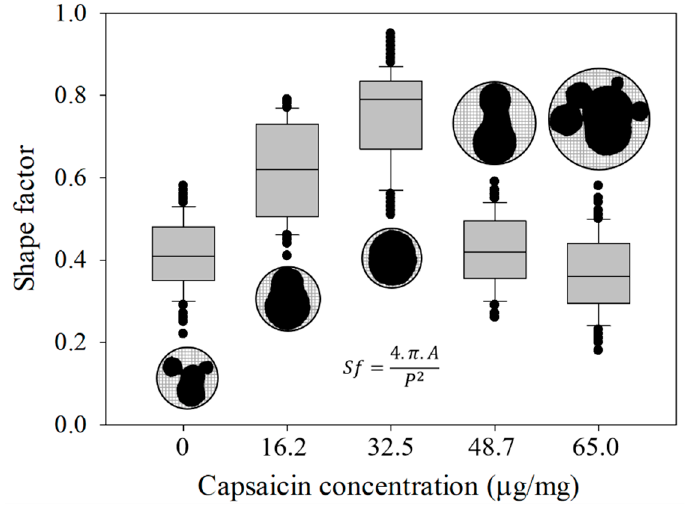
Figure 7. Shape factor of the isolated nanoparticles showed the best circular shape at 32.5 µ g / mg of capsaicin concentration. Subsequently, the increase in capsaicin concentration caused a loss of shape. The equation of shape factor ( Sf ) is also displayed. Conditions: digital measurement of n = 180 nanoparticle images at 1376 × 1032 pixels and 8 bits of compression; resolution set at 2.1 pixels / nm. Values are the means of three experimental replicates ± standard deviations.